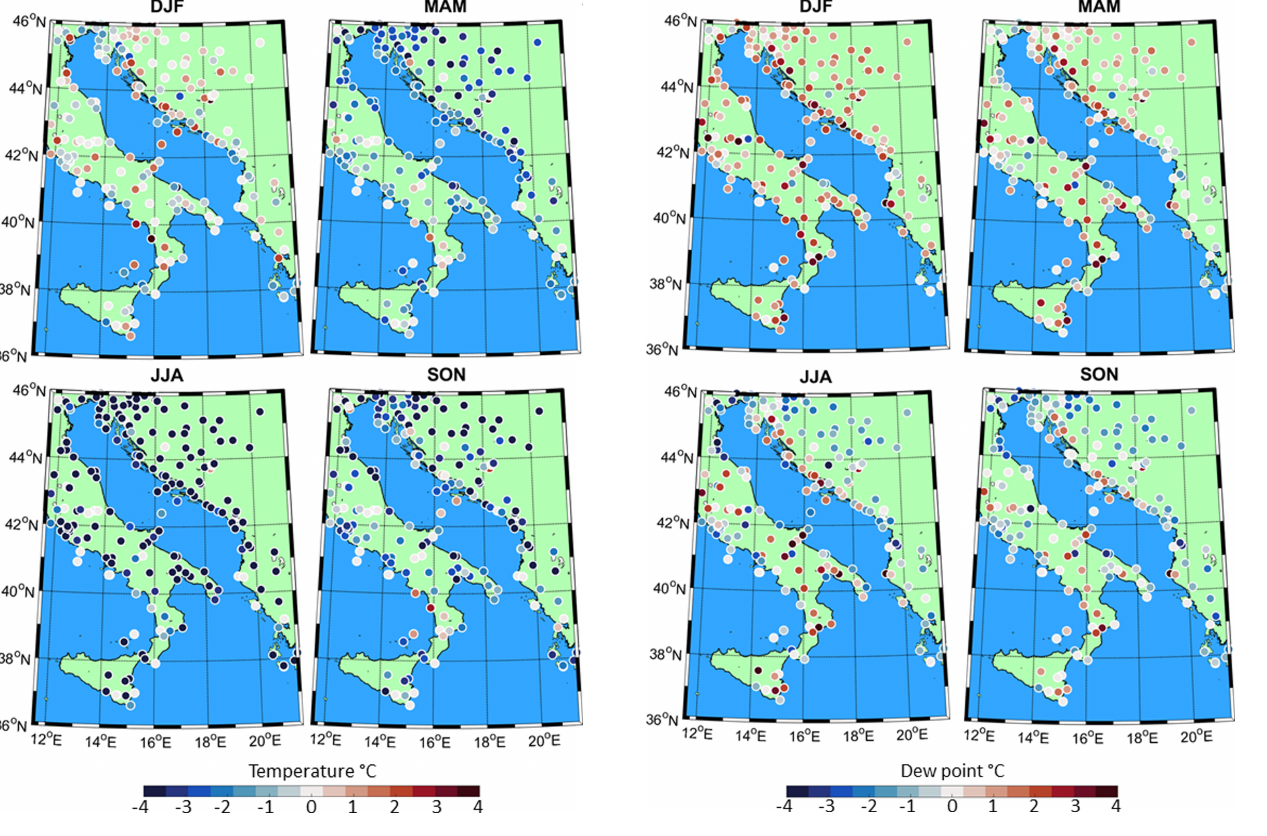
Figure 10. Seasonal variations of the median hourly temperature bias between AdriSC WRF 3km model results and NOAA land station measurements during winter (DJF), spring (MAM), summer (JJA) and autumn (SON) for the 1987–2017 period.